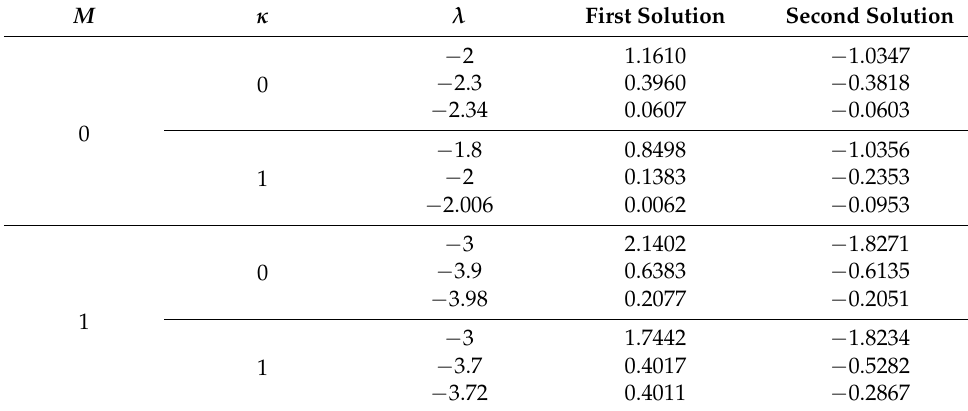
Figure 3. Velocity profiles for different M when 0 01 1 1 . , , A = = = , and 1 . = .